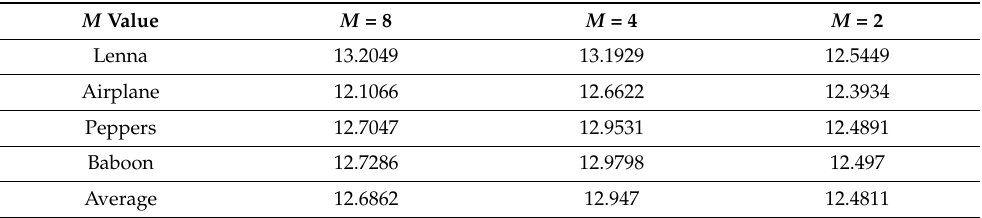
Table 2. Comparison of compression ratio in different M values.